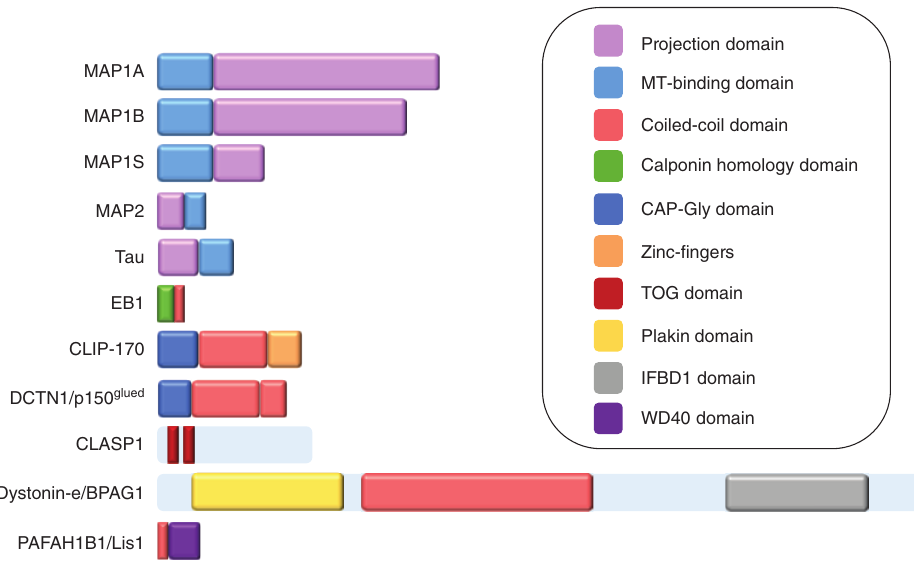
Figure 1: Examples of different MAPs and their functional domains. Some MAPs, such as MAP2 and tau, exist as multiple alternatively spliced isoforms; in these cases, the longest isoforms are shown. For MAP1 proteins, heavy chains are represented. The projection domains are the residues that extend at the surface of